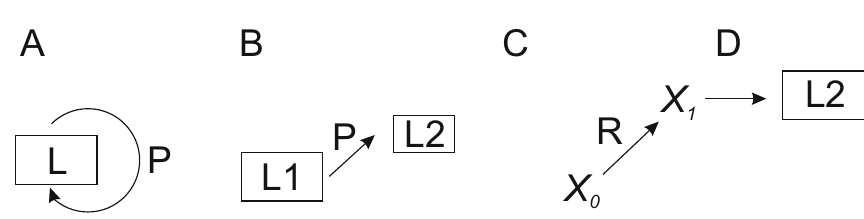
Figure4.PLTRmodelofregulation. A.TARARmechanismsrestricteffectsofperturbationPandmaintainthelagom L state of the system. B. Larger perturbation causes the system to enter from one lagom level L1 to another lagom level L2. C. Regulator R modifies entity X 0 to another functional state X 1 , after which D) the system establishes new lagom L2. Note that L2 in B and D are different. In A, B and D regulation is in lagom maintenance mode, in C in reguland regulation